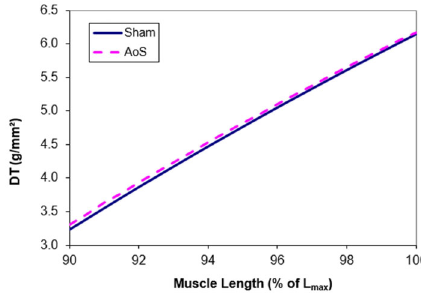
Figure 2. Relationship between muscle length variation, in % of maximum length (L max ), and developed tension (DT). AoS: aortic